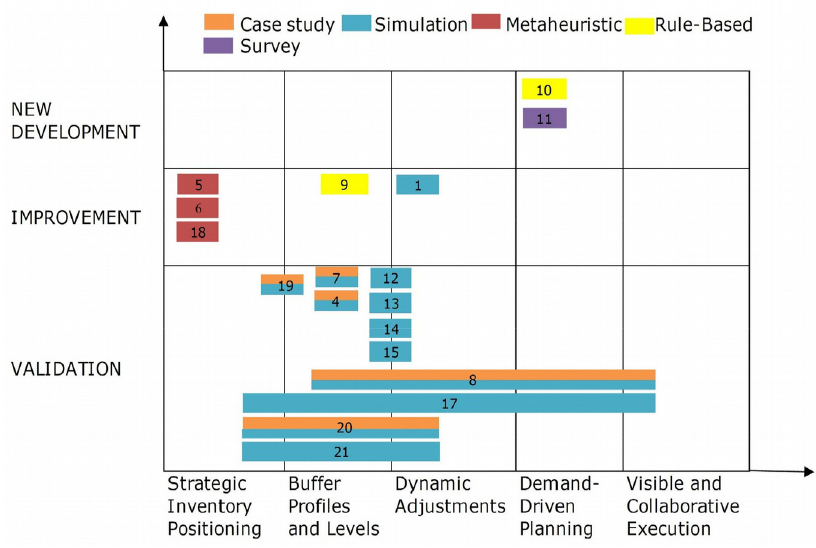
Figure 5. Analysis of used scientific